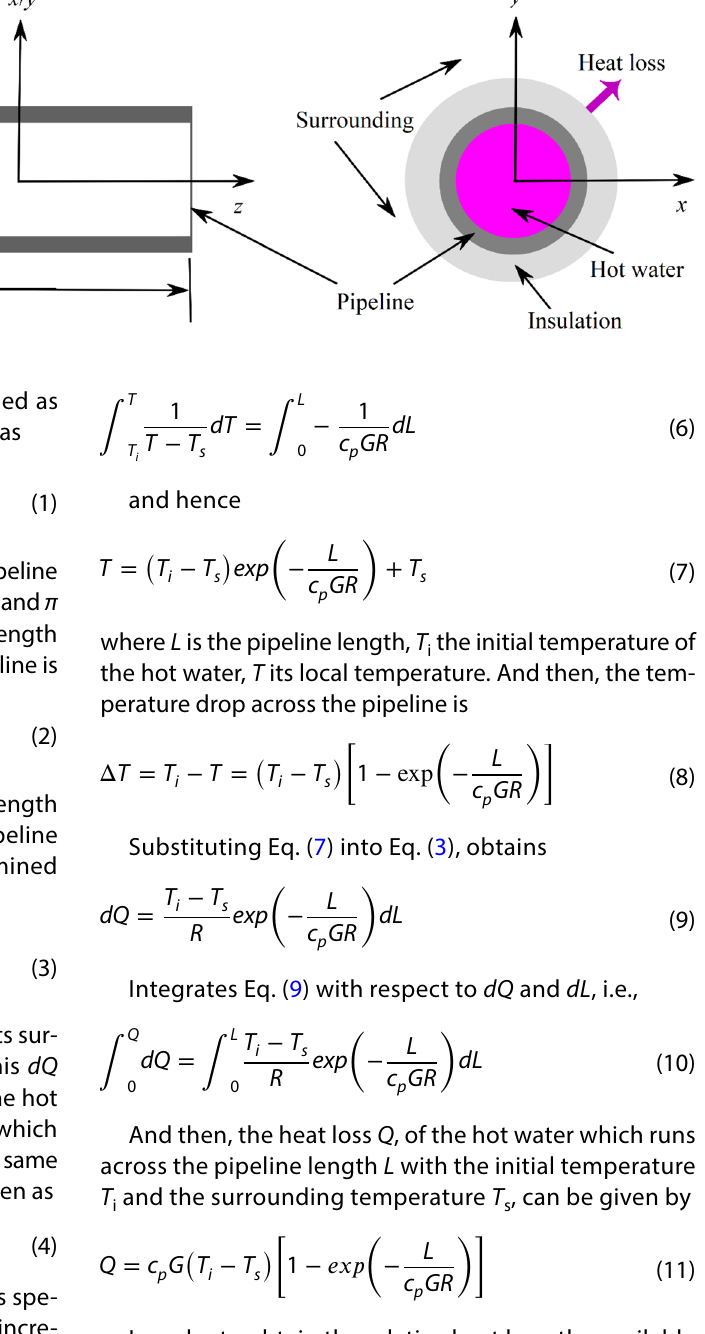
Fig. 1 Heat transport pipeline